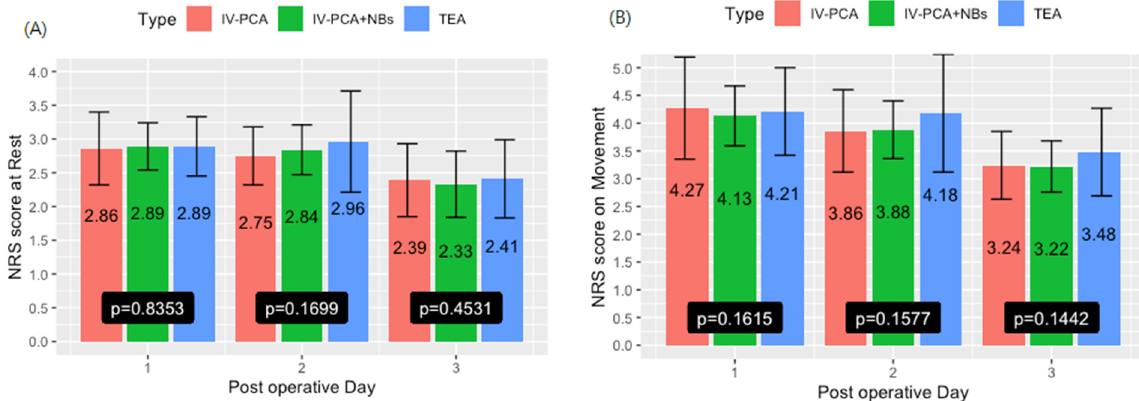
Figure 2. Numerical rating scale (NRS) scores on a scale of 10 at rest and on movement on the first three postoperative days (For better depiction, the vertical axis was drawn to up to 5 as no patients experienced NRS greater than 5). ( A ) NRS at rest on postoperative day 1, 2, and 3. ( B ) NRS on movement on postoperative day 1, 2, and 3.